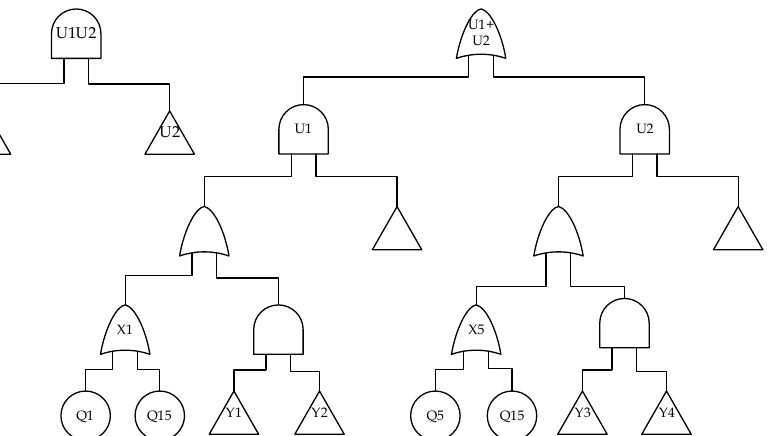
Figure 5. SCDF fault tree with seismic CCFs (Model A).